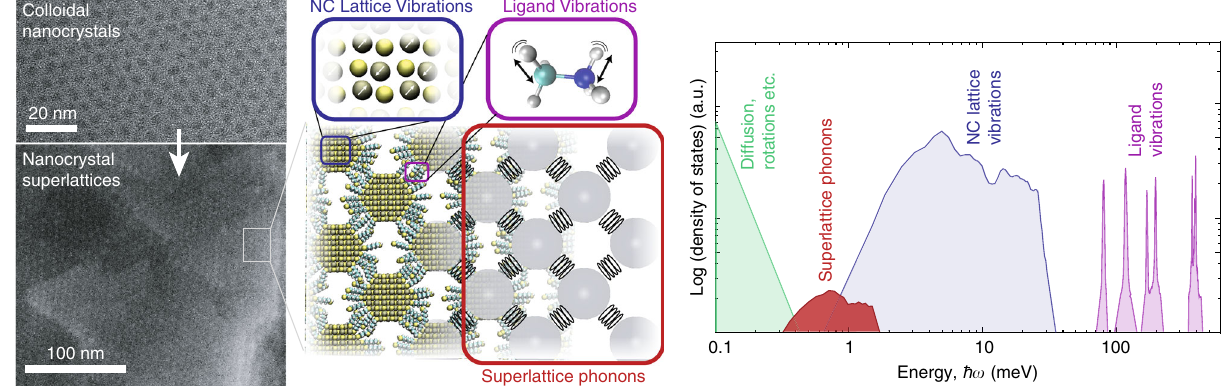
Fig. 1 Phonons in Nanocrystal Superlattices. Schematic of classes of vibrations and phonons in nanocrystal superlattices, along with an illustrative plot depicting their density of states for a PbS nanocrystal superlattice with dithiol